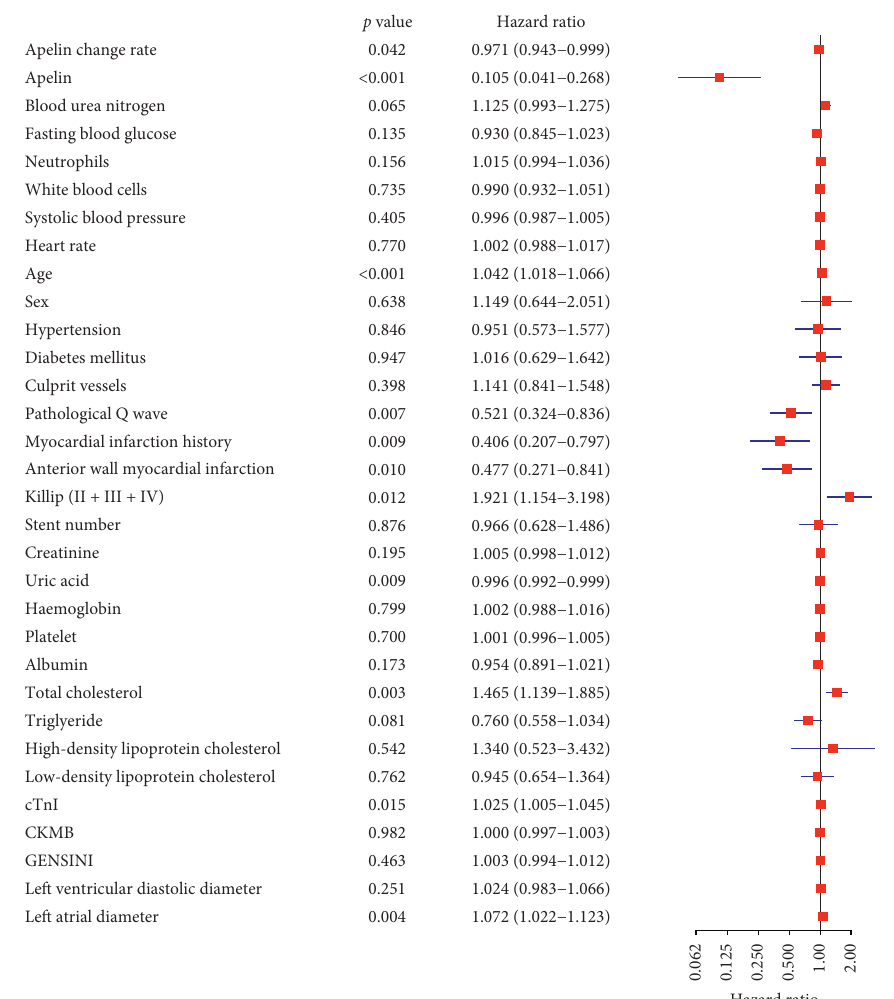
Figure 1: Multivariate Cox proportional hazards regression analysis showing the association of variables with major adverse cardiovascular